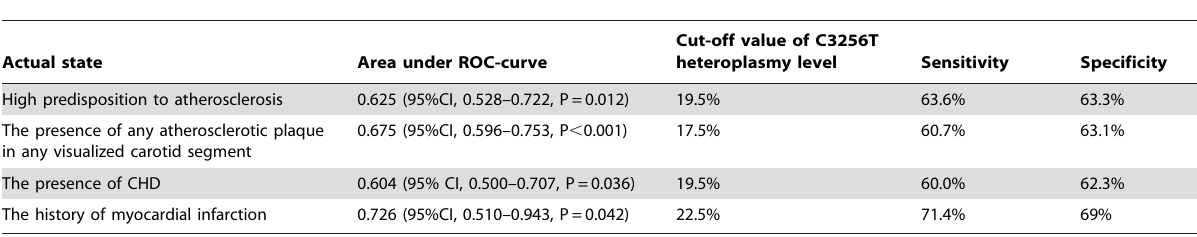
Table 2. Analysis of sensitivity/specificity ratio of C3256T heteroplasmy.